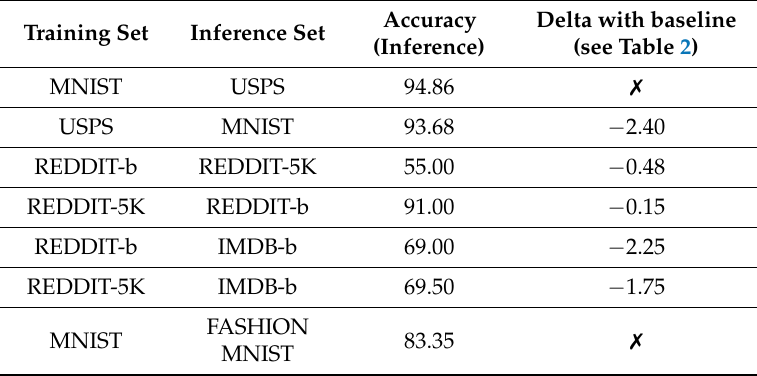
Table 3. Accuracy on classification tasks by training on some input distribution and performing inference on an other. The hyper-parameters selected are identical to the ones of Table 2. Training